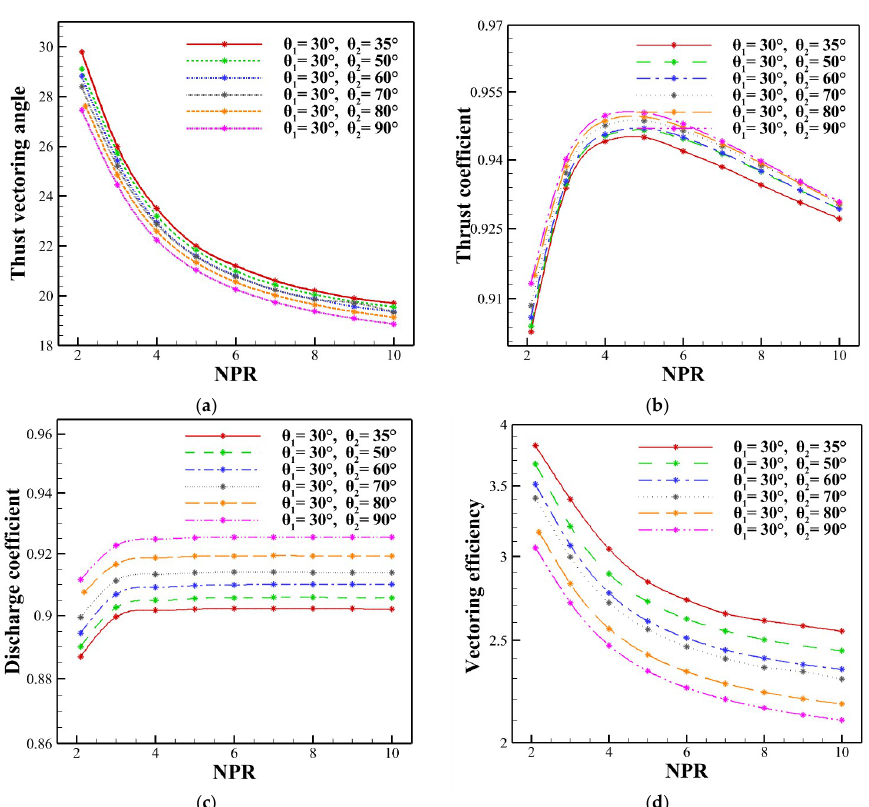
Figure 4. Variation of ( a ) the vectoring angle, ( b ) thrust coefficient, ( c ) discharge coefficient, and ( d ) vectoring efficiency with NPR for h (cid:2912) / h (cid:2930) = 0.185.